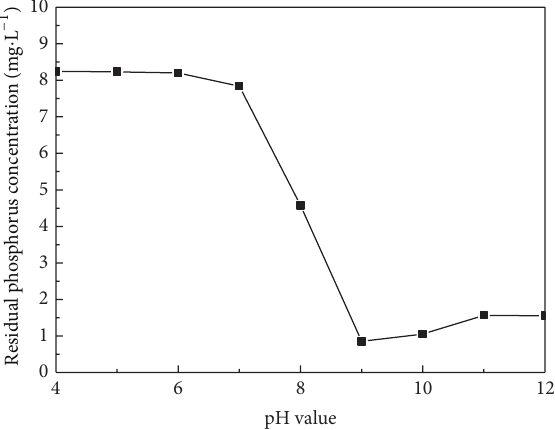
Figure 5: Influence of pH value on residual phosphate concentra-